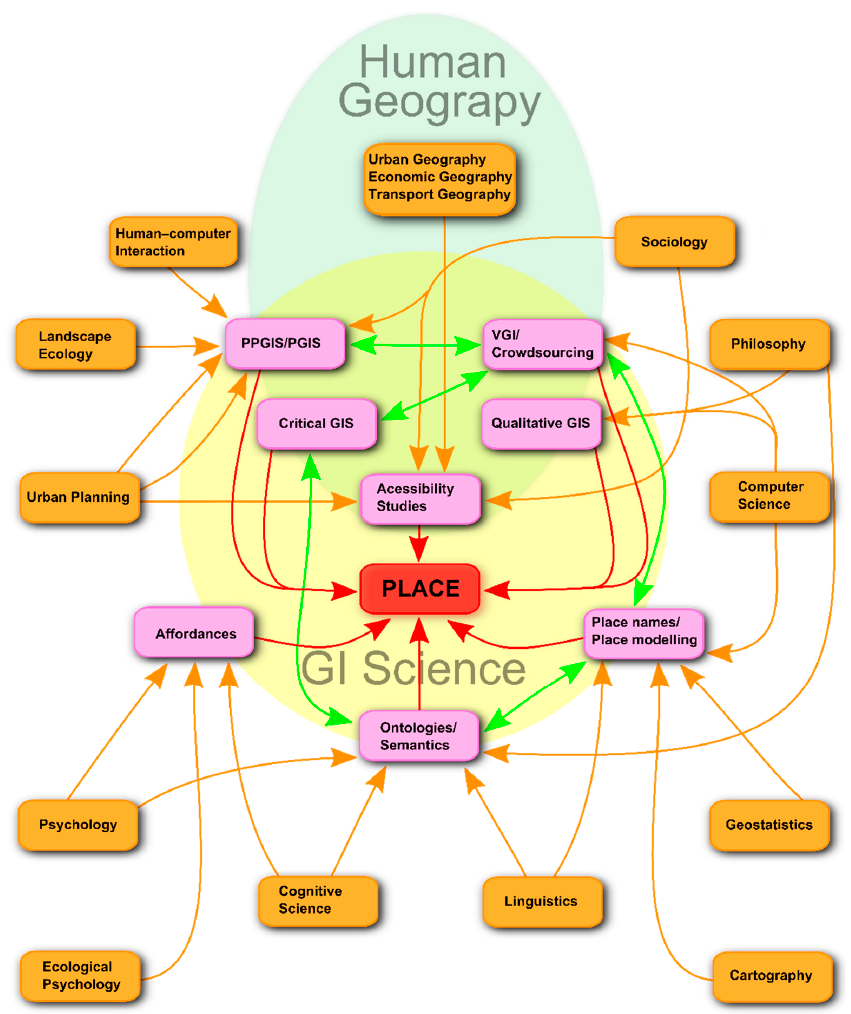
Figure 2. Disciplines identified as contributing to place research within GIScience. Table 2. Semi-quantitative analysis of the Branches of GIScience research concerned with place in Scopus